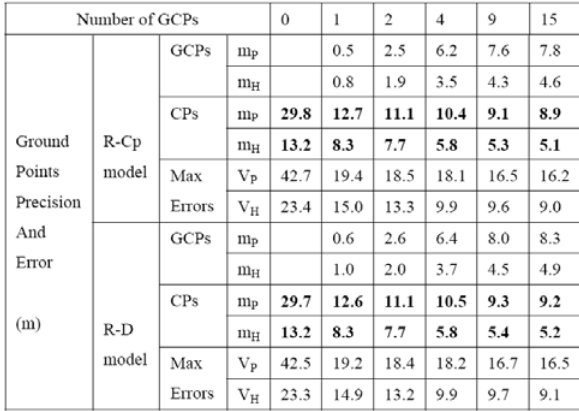
Table 1 stereo positioning accuracy statistics with same side- looking direction images